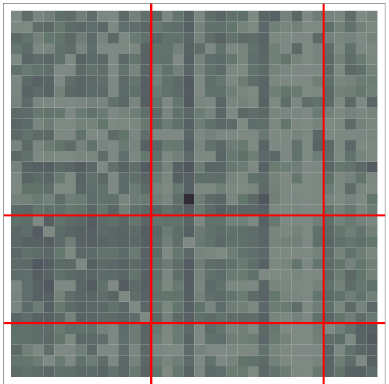
Figure 4: Asymmetric adjacency matrix of the migration graph, where darker spots mean larger numbers while lighter spots mean smaller ones. Rows and columns are ordered according to the out- and in-cluster memberships, respectively; further, the clusters and separated by red